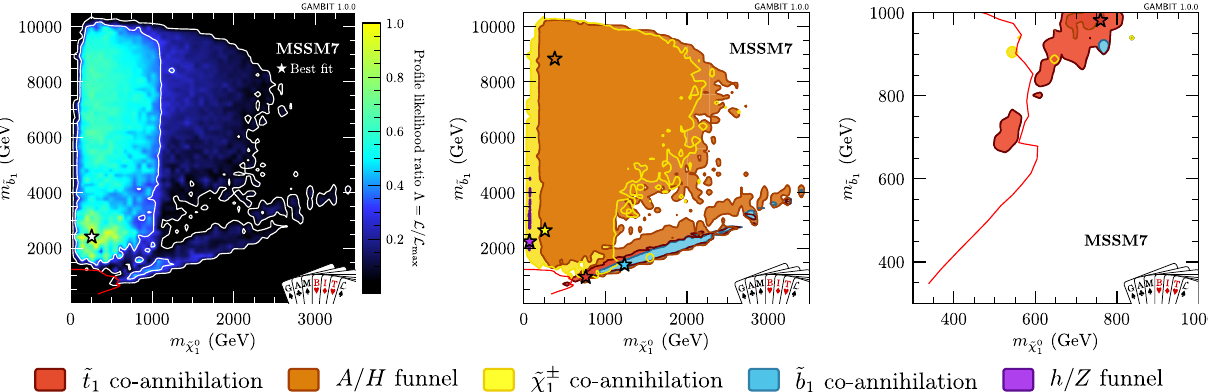
Fig. 10 Left: The profile likelihood ratio in the ˜ b 1 − ˜ χ 0 Centre: Colour-coding shows mechanism(s) that allow models within the 95% CL region to avoid exceeding the observed relic density of DM. The regions shown correspond to neutralino co-annihilation with